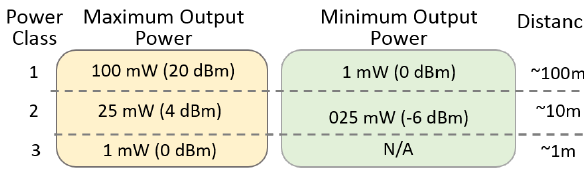
Figure 5. Bluetooth power class